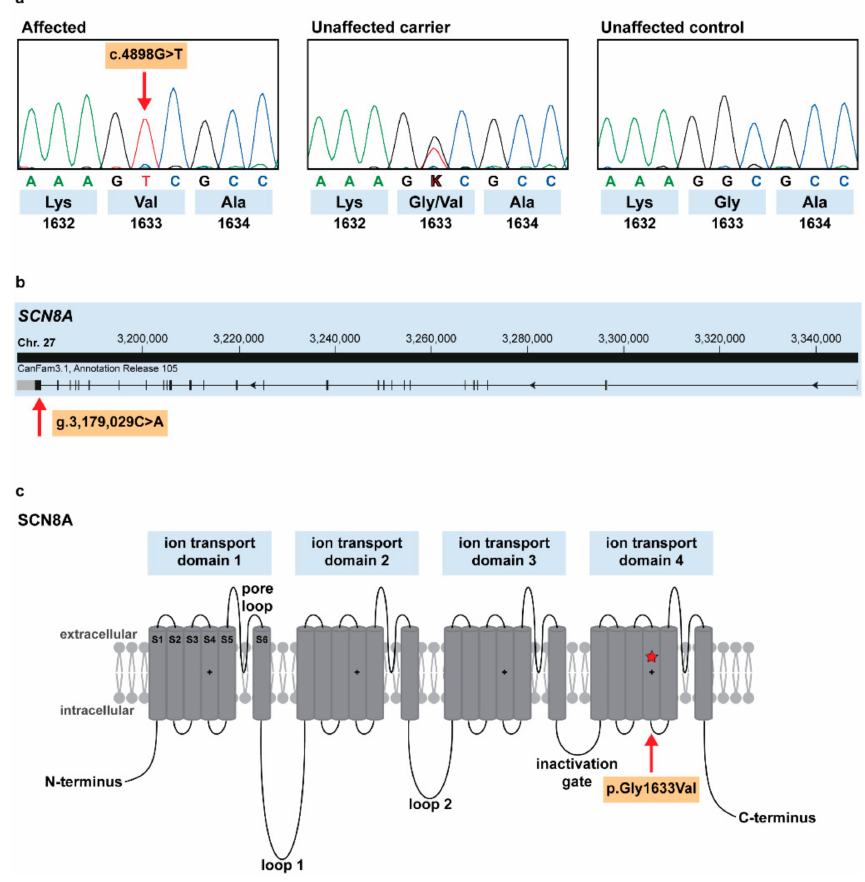
Figure 4. Spinocerebellar ataxia-associated SCN8A missense variant in Alpine Dachsbracke dogs. ( a ) Chromatograms of an a ff ected, carrier, and wild type individual dogs, indicate the c.4898G > T variant, which changes codon 1633 (shown below); ( b ) SCN8A gene structure showing the variant location in exon 27 (red arrow); ( c ) Schematic representation of SCN8A protein and its four ion transport domains, which are separated by cytoplasmic loops and a short inactivation gate, each domain contains six transmembrane segments S1–S6 (adapted from [15]). Our p.Gly1633Val variant a ff ects the positively charged S4 of the last domain (red star and